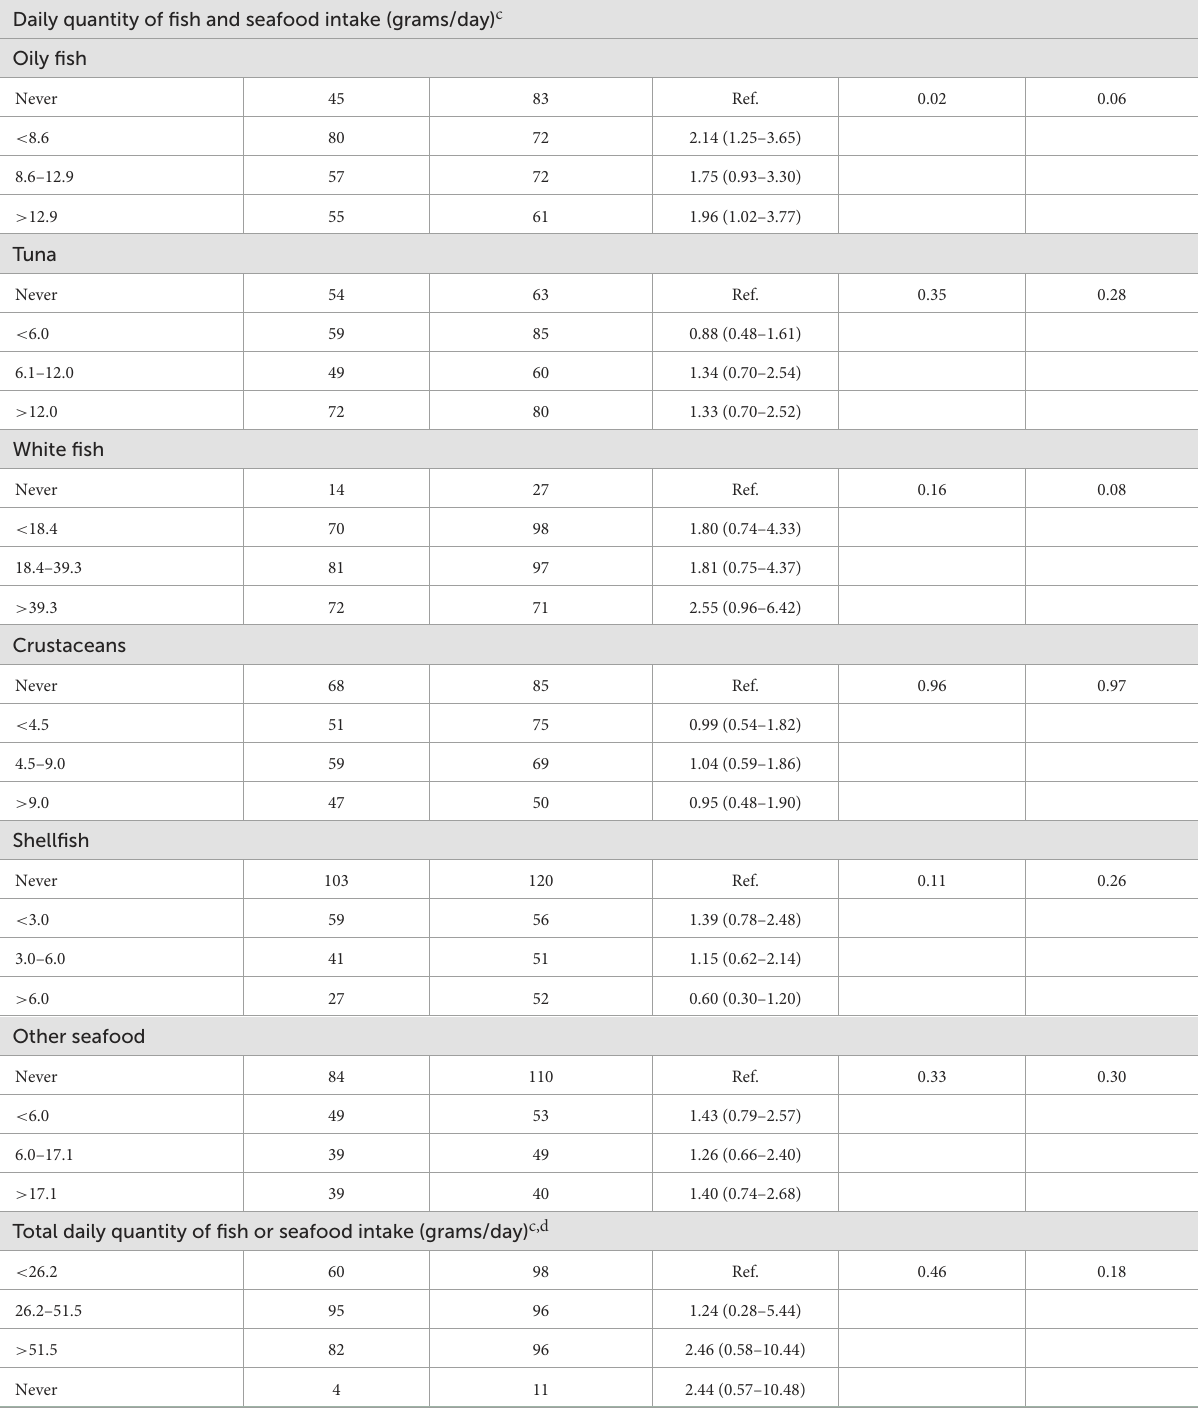
TABLE 4 Odds ratios and 95% confidence intervals for the likelihood of FL in relation to fish and seafood consumed in the year before last among cases and sibling controls.